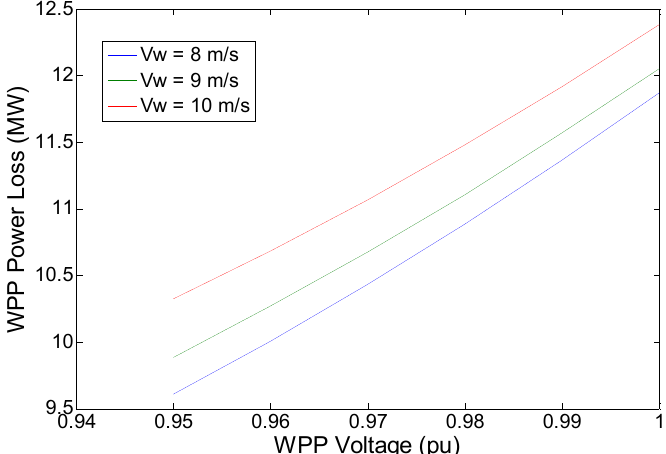
Figure 11. Variation of WPP reactive power loss. Figure 12. Variation of DFIG stator power.